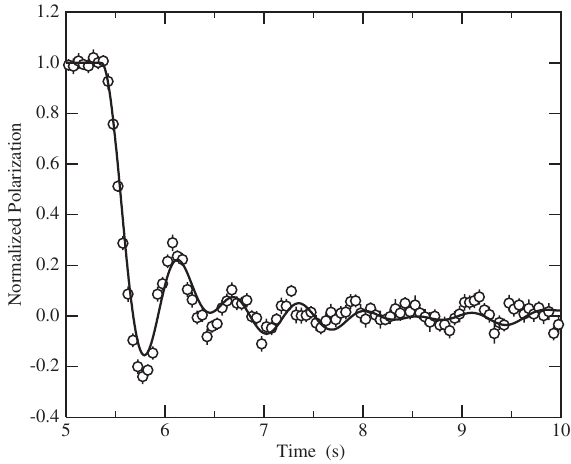
FIG. 12. Measurements made on resonance with the uncooled beam and an rf-solenoid strength of 4 : 43 (cid:2) 10 (cid:1) 6 rev = turn